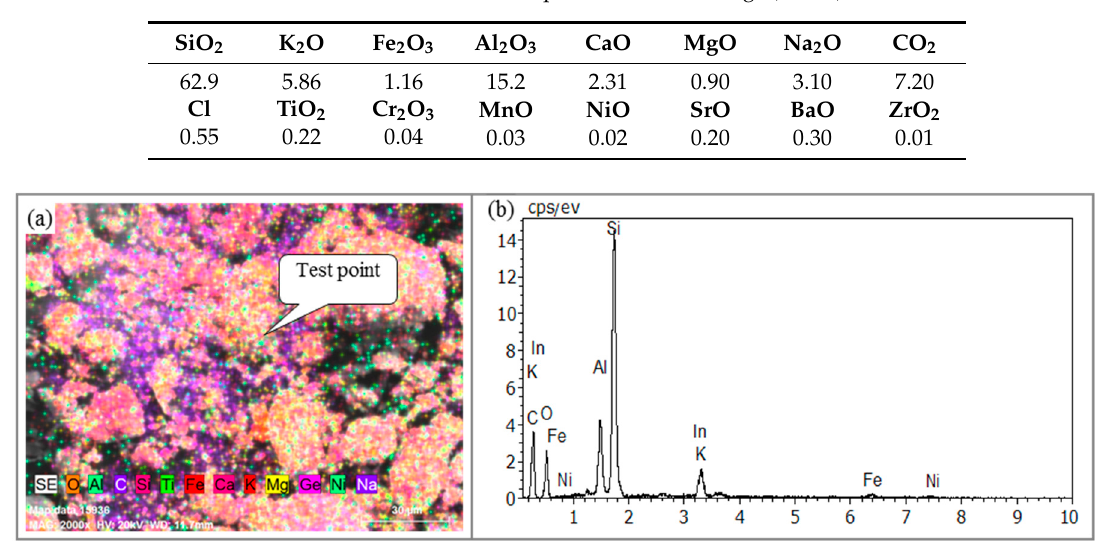
Figure 3. ( a ) Particle size distribution and ( b ) microstructure of the tailings.